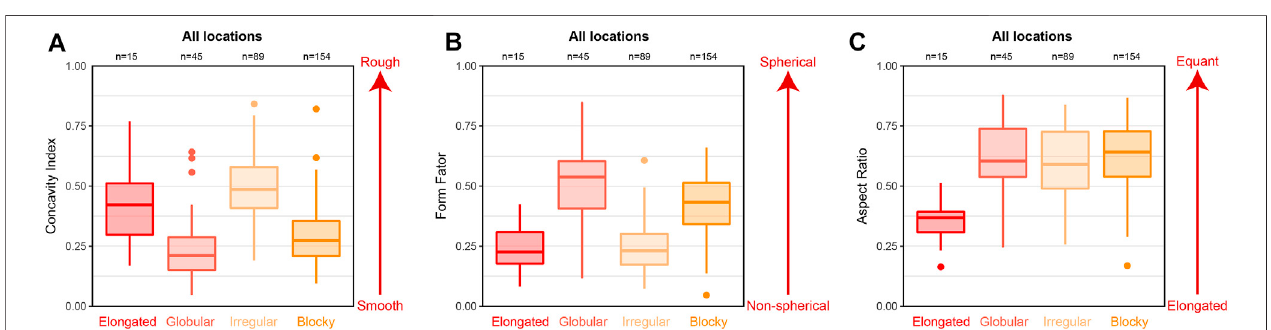
FIGURE6| ConcavityIndex,FormFactorandAspectRatioofthe125 – 180 µmfractionfromallthestudiedlocations,separatedbymorphologicalcomponentand represented by Tukey Whiskers plots (see caption of Figure 5 for a description of these boxplots). A subset of randomly picked SEM images from the 125 – 180 µm fraction was used to assess these shape parameters on the individual morphological components.